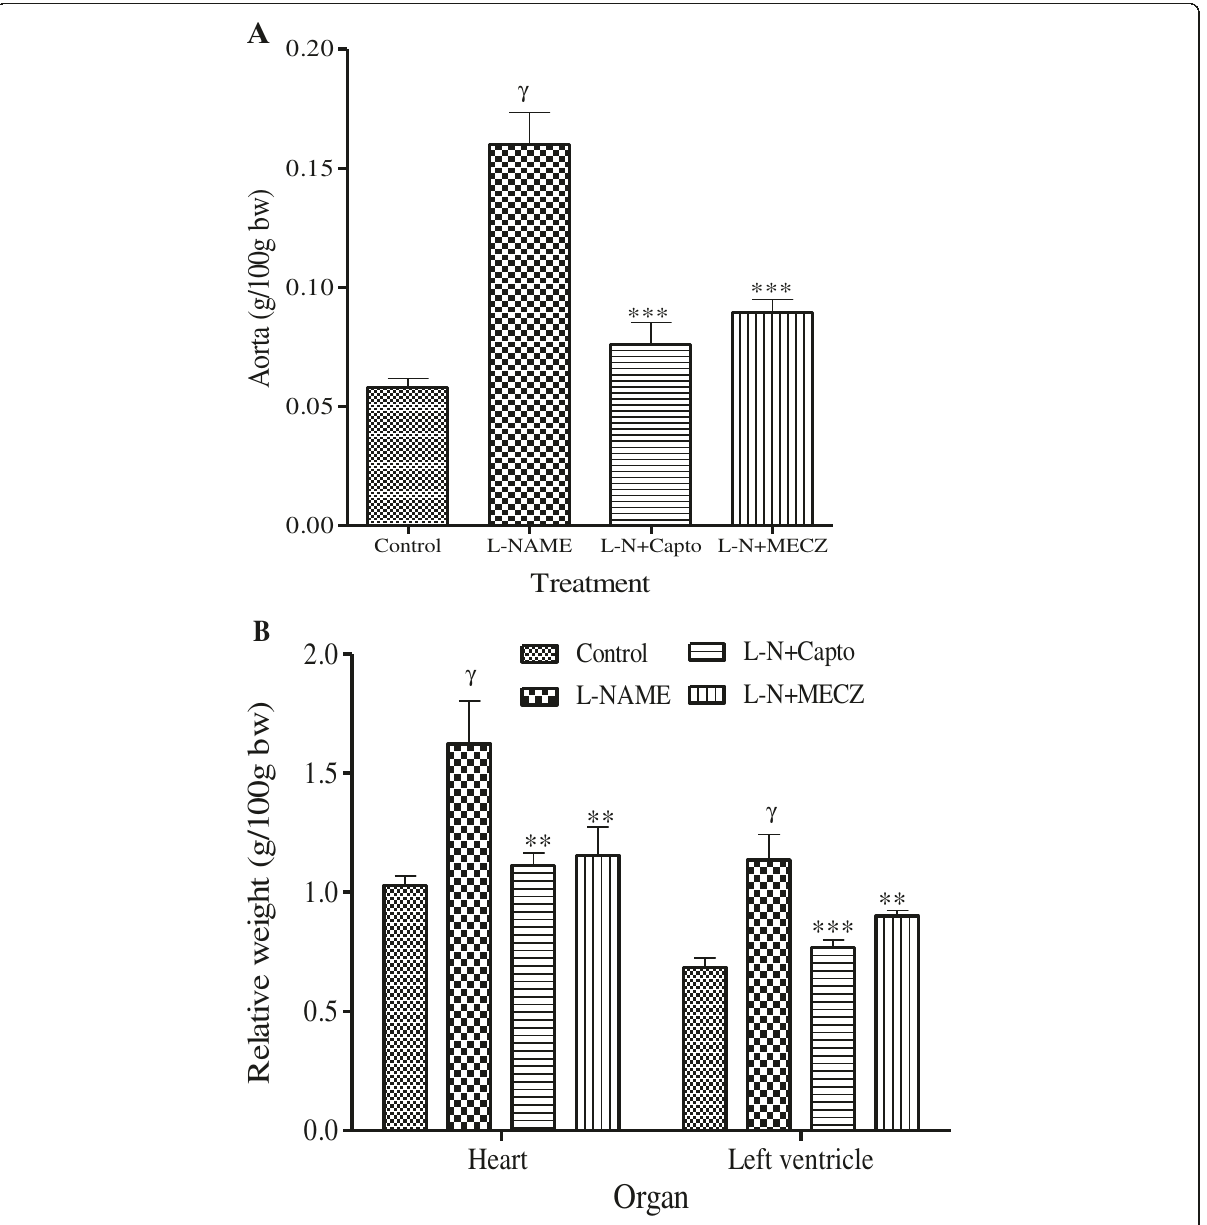
Figure 4 Effects of the chronic treatment on the aorta, heart and left ventricle relative weight. Values are Mean±SEM (n=5); γ p<0.001 significantly different compared to the control group; **p<0.01 and ***p<0.001 significantly different compared to the L-NAME